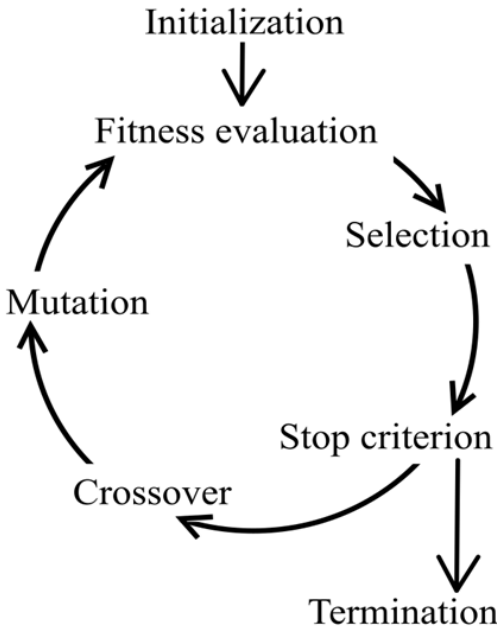
Figure 2. The scheme of the evolutionary algorithm